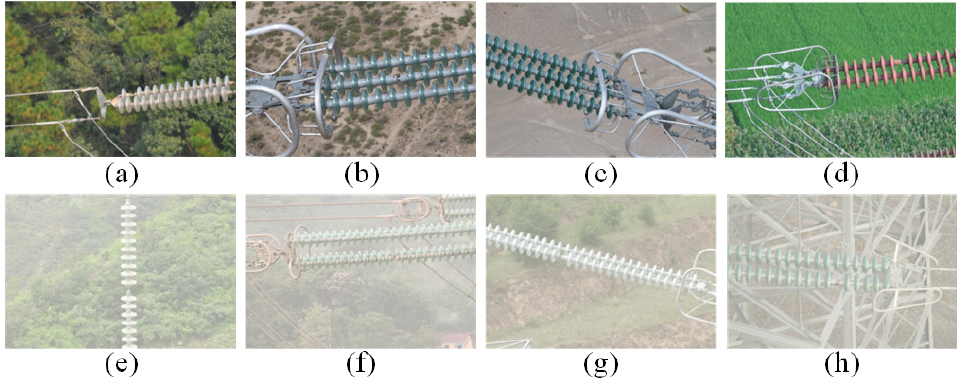
Figure 2. Images of insulators in foggy and fog-free weather conditions. ( a – d ) Clear images. ( e – h ) Foggy